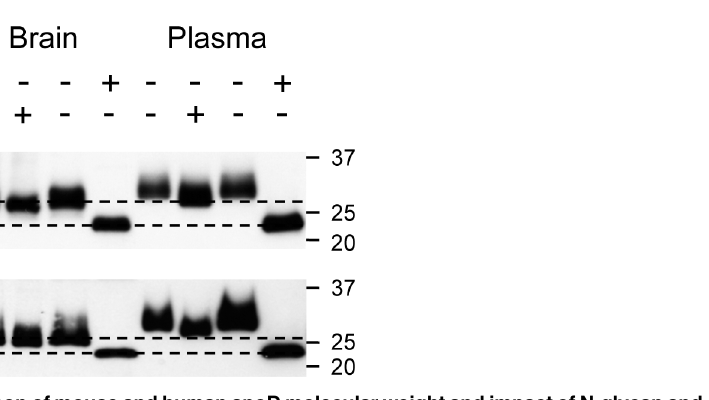
Fig 5. Comparison of mouse and human apoD molecular weight and impact of N-glycan and sialic acid removal. Mouse and human brain and plasma samples were separated by PAGE under conditions that yielded approximately equal apoD loading. Both brain and plasma samples were pre-incubated with either PNGase ( “ + ” ) or NMDase ( “ + ” ), or the appropriate buffer controls ( “ - “ ), to assess the impact of N-glycans and sialic acids, respectively, on overall MW. The broken lines clarify the migration distances of the different samples and indicates that the differences in MW (comparing brain and plasma samples) are not due to sialylation alone (as the MW of plasma apoD is still greater than that of brain apoD after sialic acid removal). In addition, the difference between brain and plasma apoD MW identified in the mouse samples are recapitulated in the human brain and plasma samples. PNGase, peptide N-glycosidase F; NMDase,